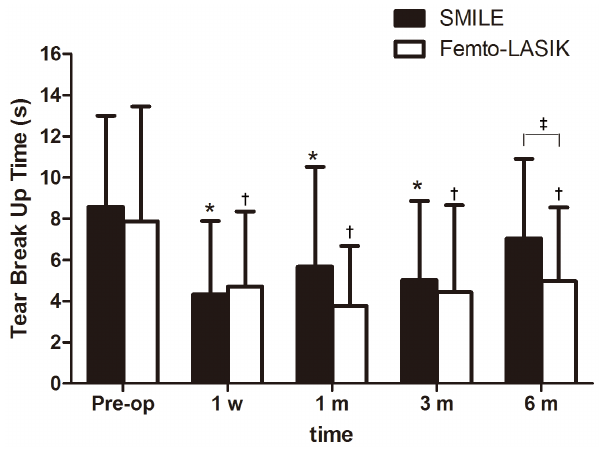
Figure 3. Time dependent changes in the Schirmer test results (mean ± SD, mm) after small incision lenticule extraction (SMILE) and femtosecond LASIK (femto-LASIK). *Significantly shorter than the preoperative level (SMILE; P , 0.05). { Significantly shorter than the preoperative level (femto-LASIK; P , 0.05).